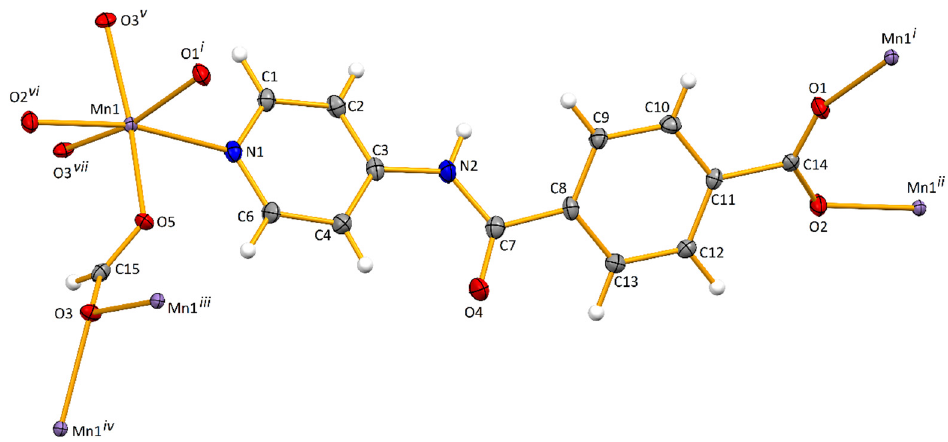
Figure 1. Ellipsoid plot (drawn at 50% probability level) of Mn-CP with atom labelling scheme. Symmetry operations to generate equivalent atoms: ( i ) − x,1 − y, − z; ( ii ) − 1 + x,y,z; ( iii ) x,1/2 − y, − 1/2 + z; ( iv ) 1 − x, − 1/2 + y,1/2 − z; ( v ) 1 − x,1/2 + y,1/2 − z; ( vi ) 1 + x,y,z; ( vii ) x,1/2 − y,1/2 + z.